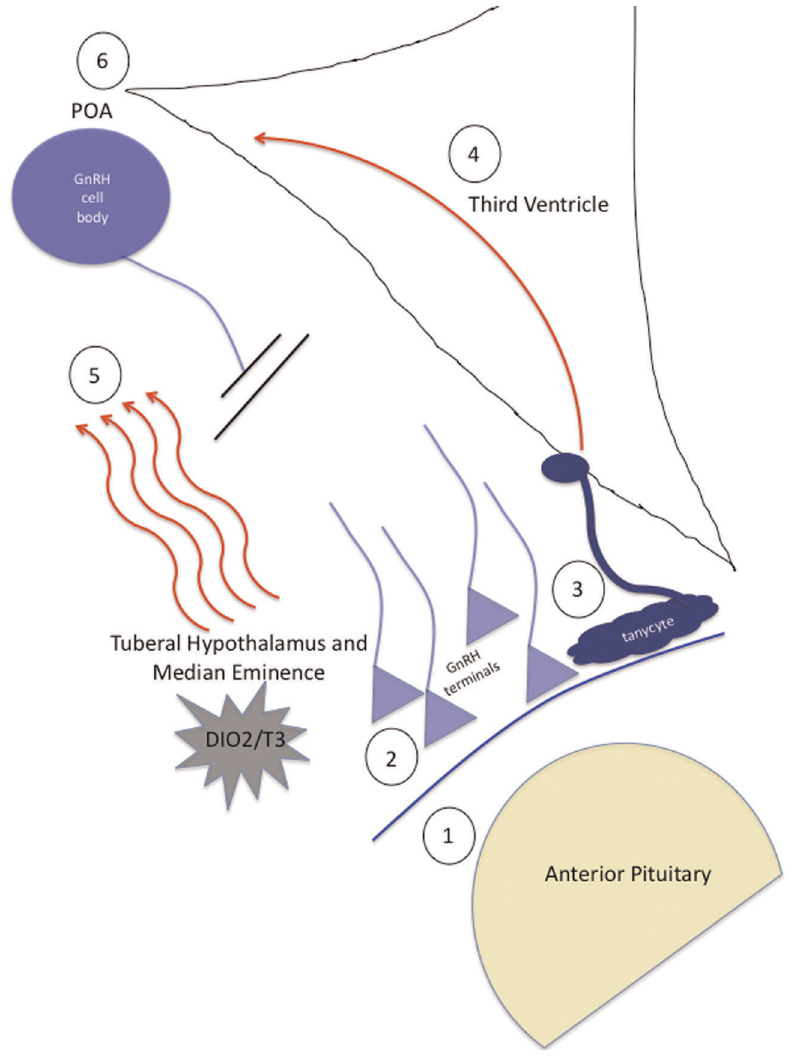
Figure 3. Schematic demonstrating the potential modes of action of T3 to elicit GnRH release at the median eminence ( at 11 hrs ) and later ( at 18 hrs ) on GnRH cell bodies in the preoptic area ( POA ). T3 could act directly on the pituitary (1) or on GnRH terminals in the ME (2), causing release of GnRH there, or on glial cells causing retraction and then allowing localized release of GnRH in the fiber terminals (3). Several hours later, photostimulation causes up-regulation of GnRH expression potentially from action of T3 on tanycytes surrounding the third ventricle that send a signal to GnRH neurons (4), or from diffusion of locally produced T3 to the POA (5) or via a totally separate mechanism (6).